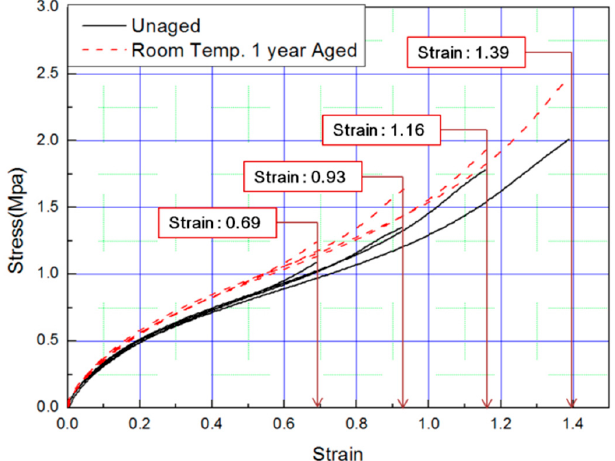
Figure 14. Tensile curves for specimen aged for one year.